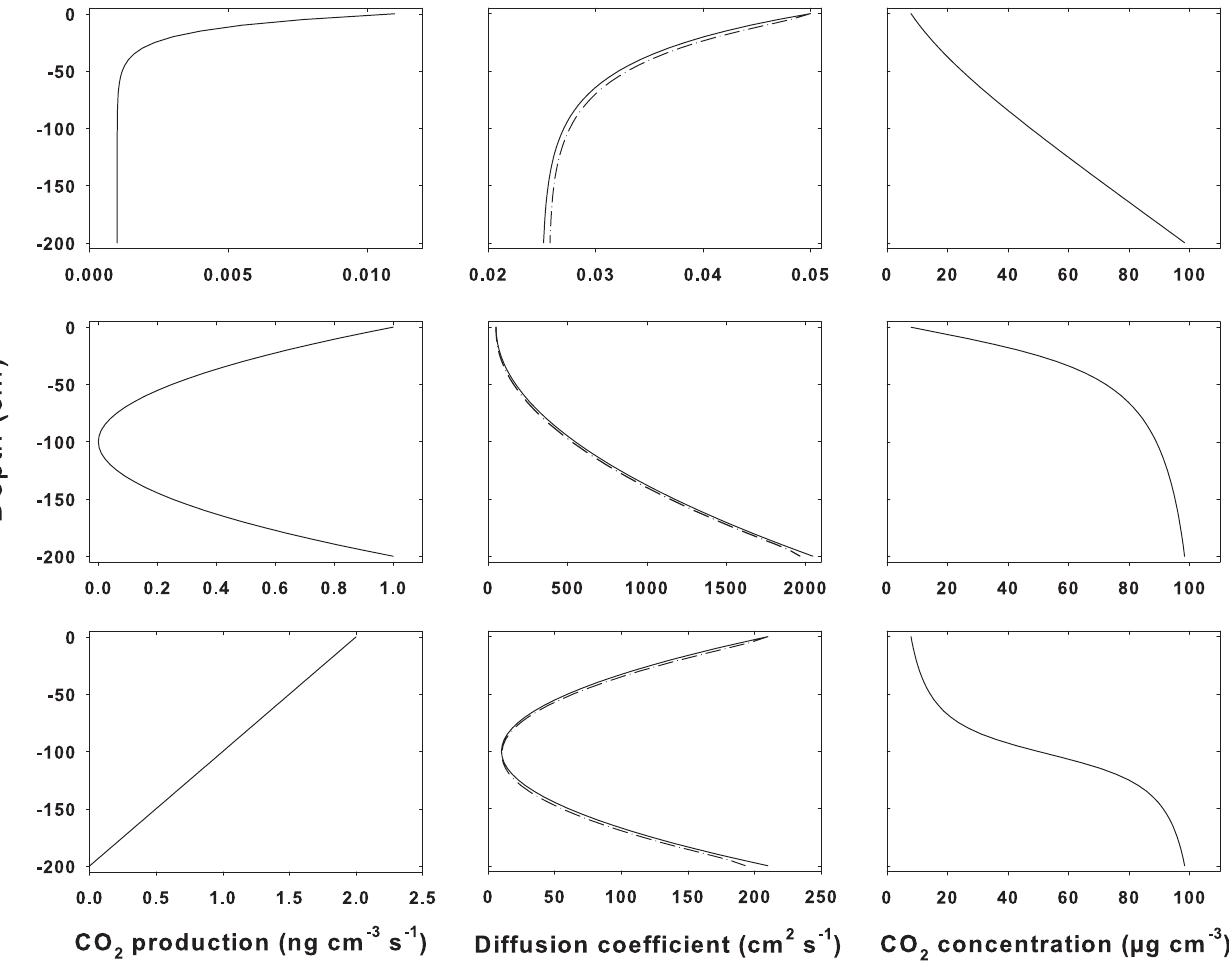
Fig. 5. The solid lines show three examples of arbitrary profiles for CO 2 production (left column) and diffusion coefficients (middle column) which, when solving the CO 2 mass balance equation considering only gaseous diffusion as assumed in the soil-CO 2 profile method (Eq. A6), give the steady state CO 2 concentration profiles shown in the right column. The dotted line in the middle column shows the inversely modeled D which was numerically calculated from the steady state CO 2 profiles as described in Sect.